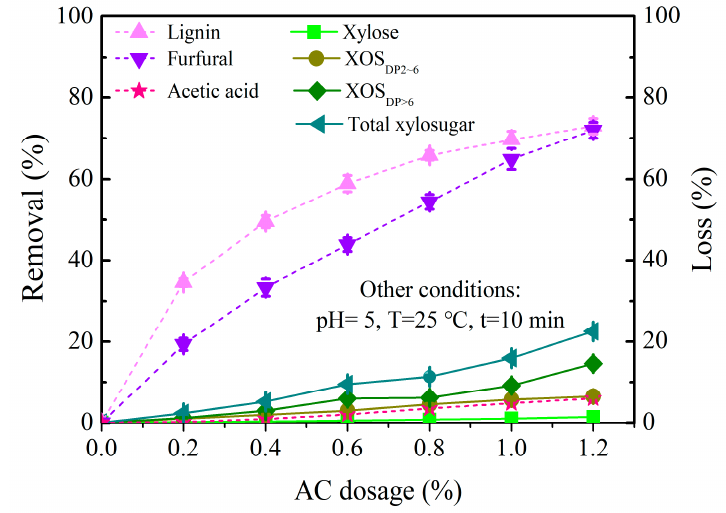
Figure 5. Influence of AC dosage on the removal of lignin, furfural, acetic acid and the loss of xylose, XOS DP2~6 , XOS DP > 6 , and total xylosugars of the CH-treated PHL.